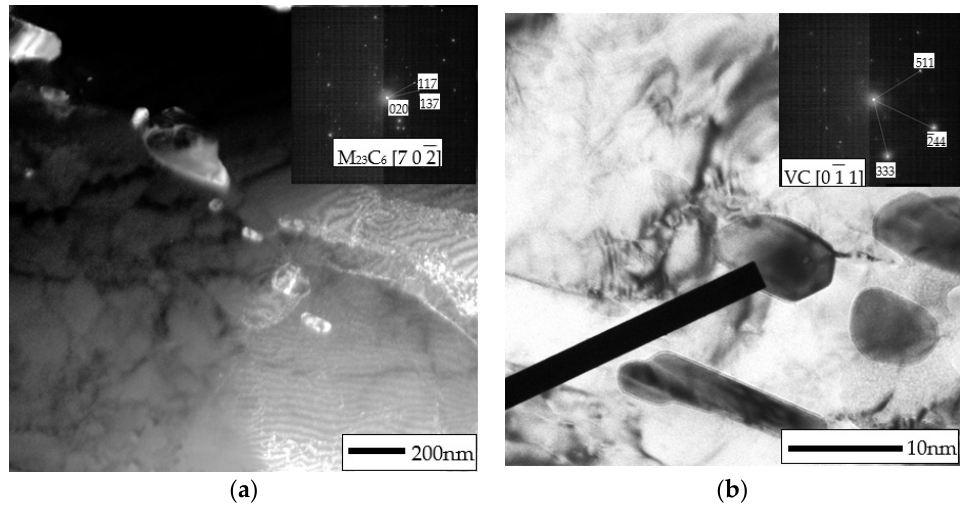
Figure 4. Precipitates in Thor 115 steel in initial condition: ( a ) M 23 C 6 ; ( b ) MC.